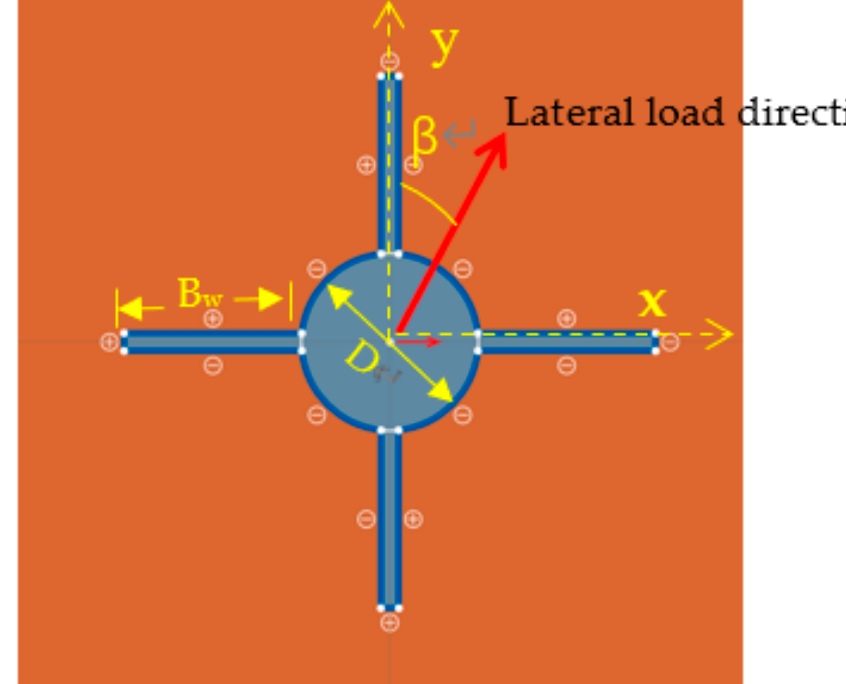
Figure 3. Calculated section of four-wing pile.